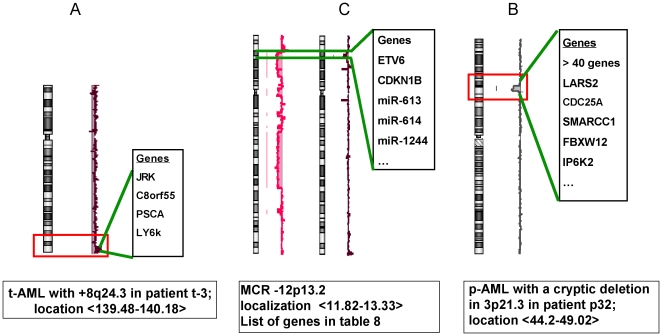
Details of critical rearrangements concerning MCRs.A = gain on 8q24.3 in a t-AML; B = loss of 12 p13 in t-AML (patients t-4 and t-5); C loss of 3p21.3 in a p-AML.